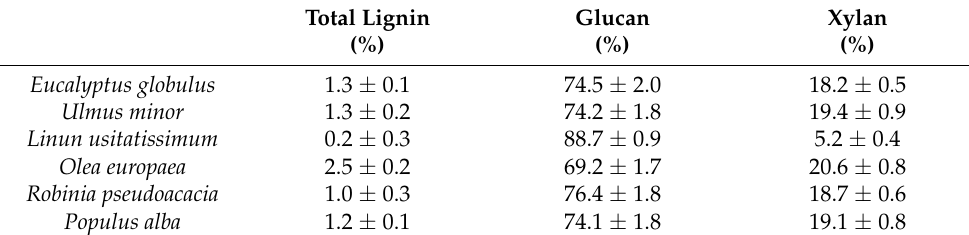
Table 1. Chemical composition of cellulose samples (weight percentage %).